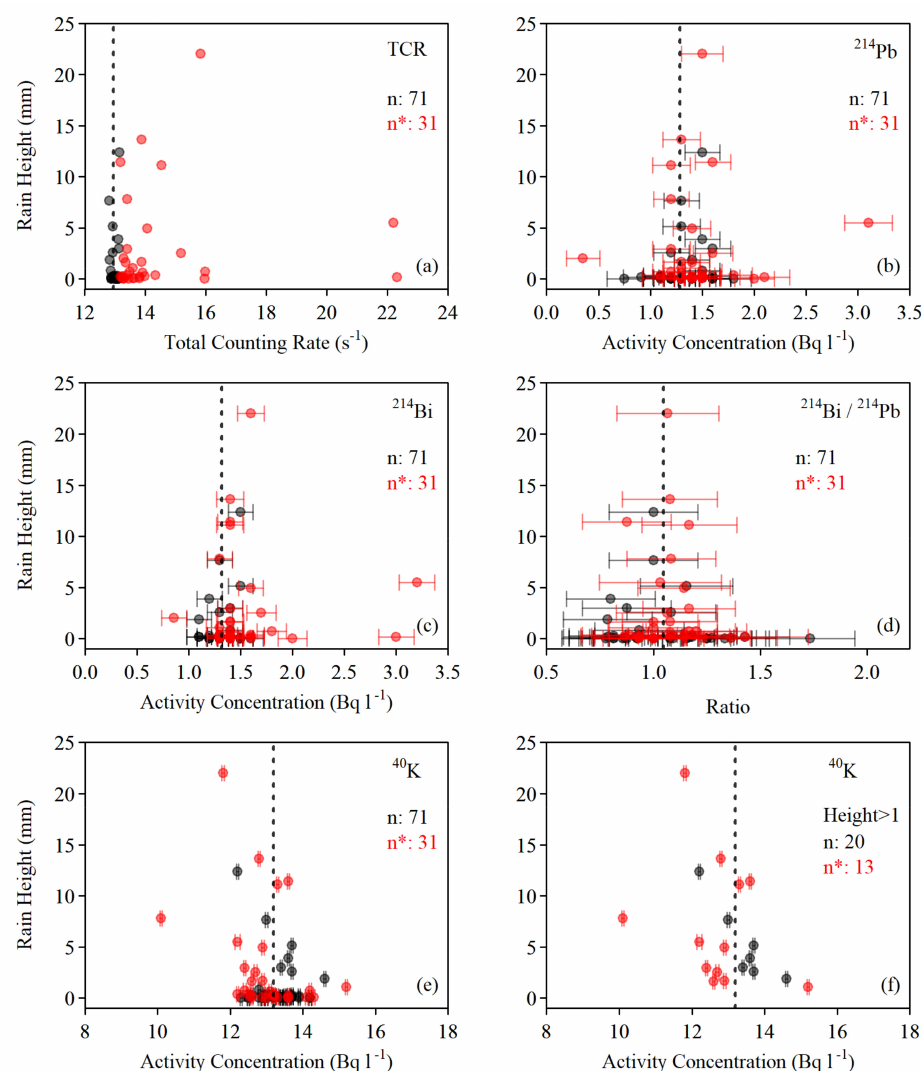
Figure 8. The rainfall height over TCR ( a ), 214 Pb ( b ), 214 Bi ( c ), radon progenies ratio ( d ), 40 K ( e ) and 40 K ( f ) for rain heights higher than 1 mm. The total number of events is n, and the events of statistically significant variation of TCR (n*) are presented with red dots. The mean value of each parameter during dry meteorological periods is presented with dotted